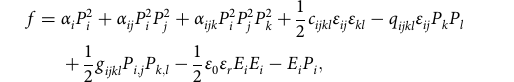
and then stepped down to a fi nal cleaning voltage of 0.3kV.